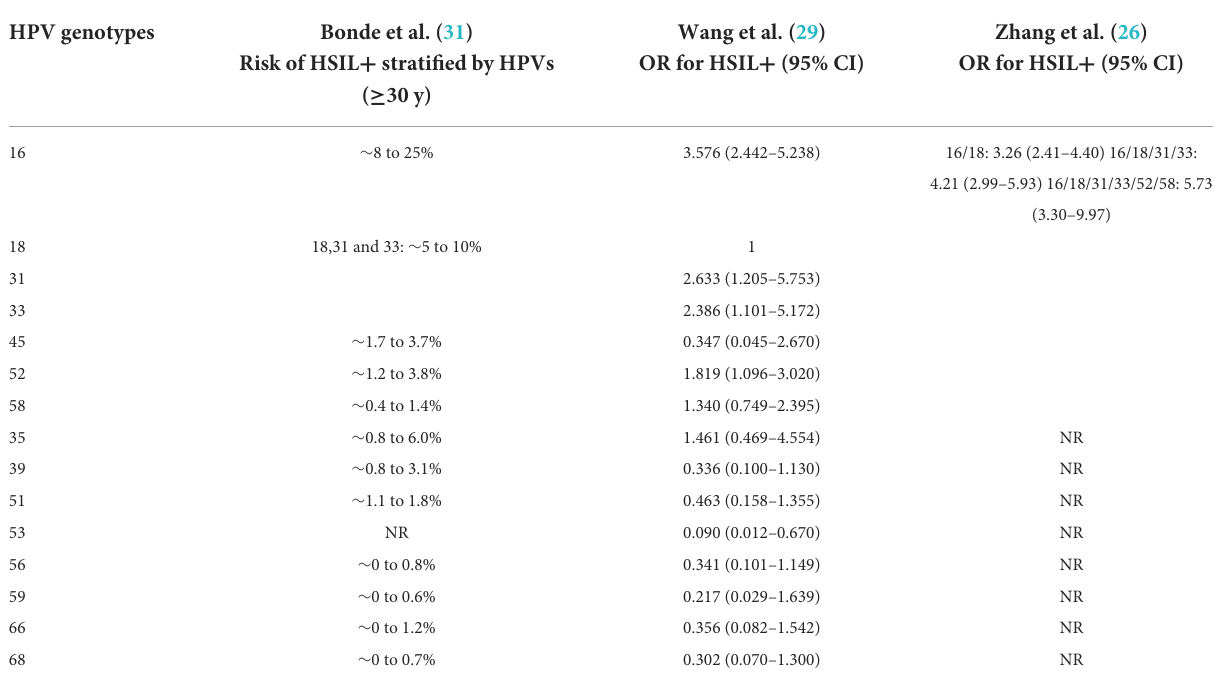
TABLE 2 Risk of progression to cervical preneoplastic lesions.